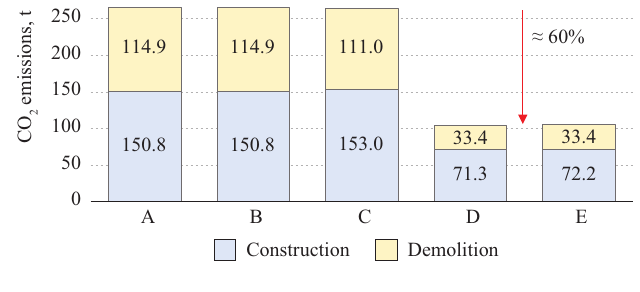
Figure 2. Amount of CO 2 emissions for all five alternatives in the 40-year